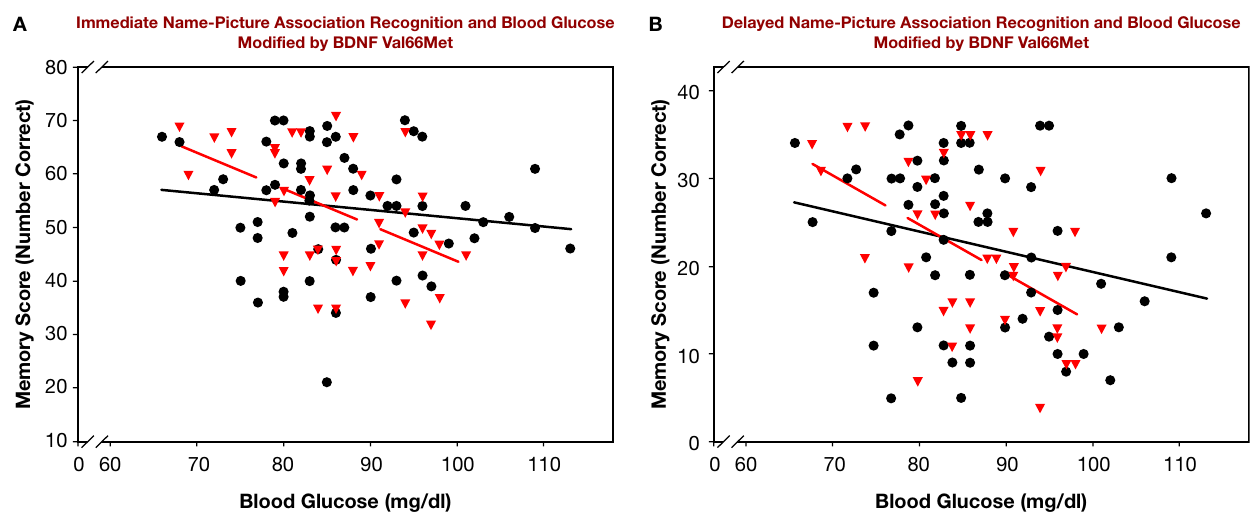
Figure 1 | Name-picture association recognition and blood glucose modifi ed by BDNF Val66Met genotype. BDNF Val66Met Met carriers (red triangles, broken regression line) are compared to BDNF Val homozygotes (black circles, solid regression line). (A) Immediate recognition. (B) Delayed recognition.